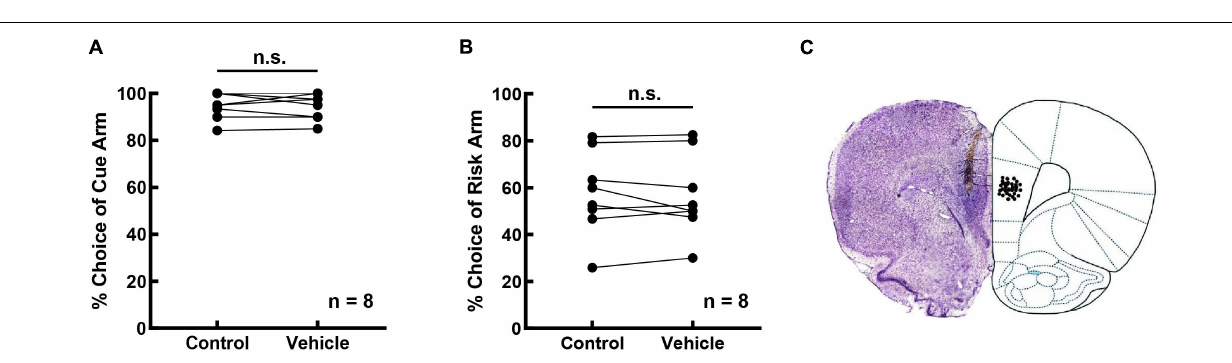
FIGURE 5 | Intra-mPFC infusion of vehicle did not affect risky decision-making. (A) Vehicle did not affect the cue recognition ability of rats when tested in the cue-test blocks. (B) Vehicle did not affect the risk strategies held by rats when tested in the free-choice block. (C) An example for the location of drug infusion in the mPFC. Brain sessions were stained with Nissl’s